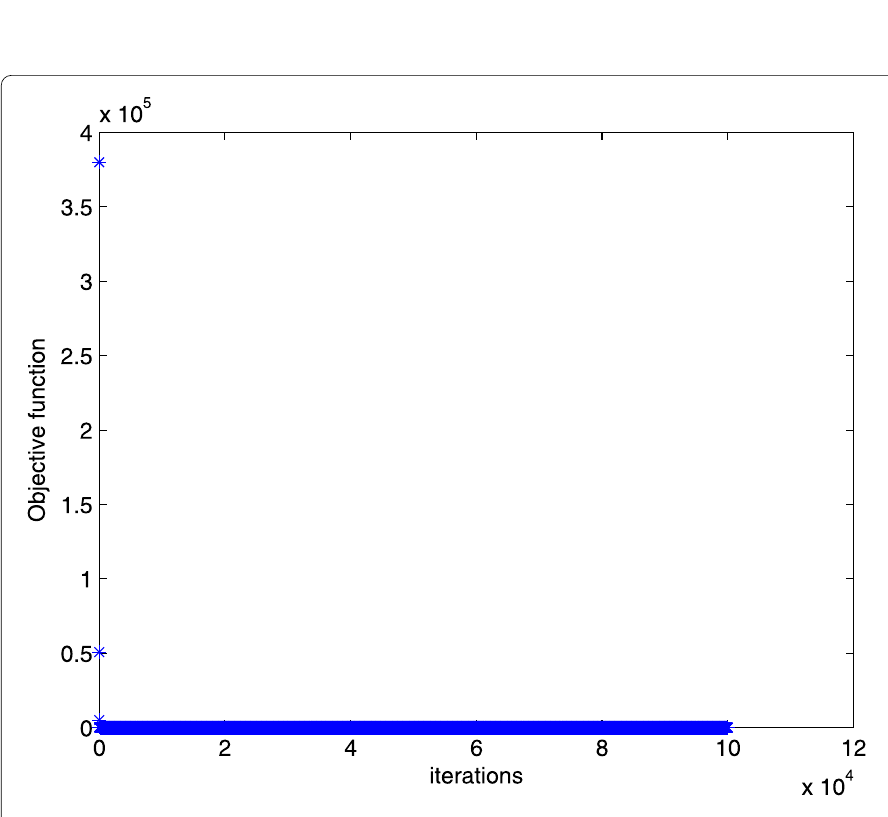
Figure 4 Numerical results for solving Example 2 with smoothing gradient